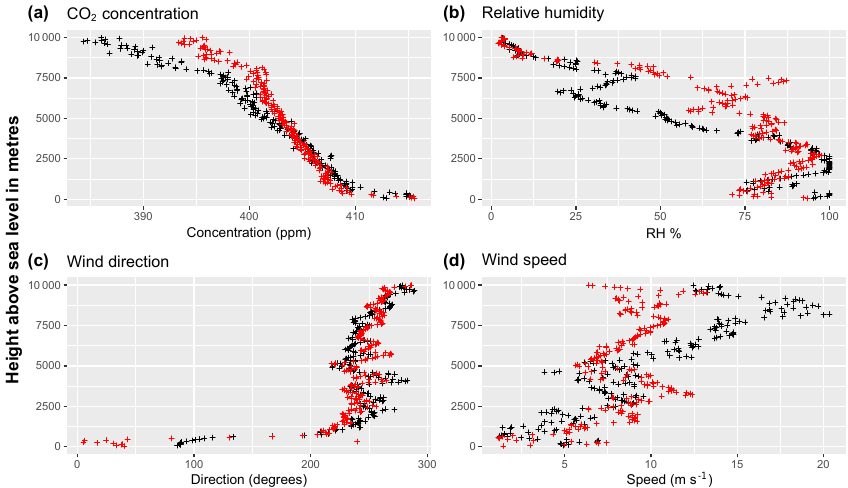
Figure 7. Preliminary balloon-borne CO 2 data launched on 14 April 2016 from Weybourne Atmospheric Observatory, UK (Fig. 1). Correl- ative measurements of (b) relative humidity, (c) wind speed, and (d) wind direction are also shown. Data are averaged every 10s. Red ticks denote the morning launch, and black ticks denote the afternoon